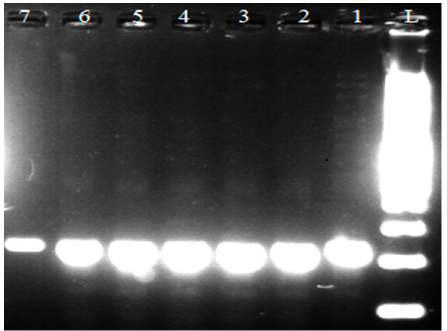
Figure 1. Identification of genus Lactobacillus sp . L: 100 bp ladder standard; lines 1, 2, 3, and 4: isolates of Lactobacillius sp. (250 bp); line 5: Lb. johnsonii reference strain CCM 2935; line 6: Lb. zeae reference strain CCM 7069; line 7: Lb. paracasei reference strain CCM 4649 .